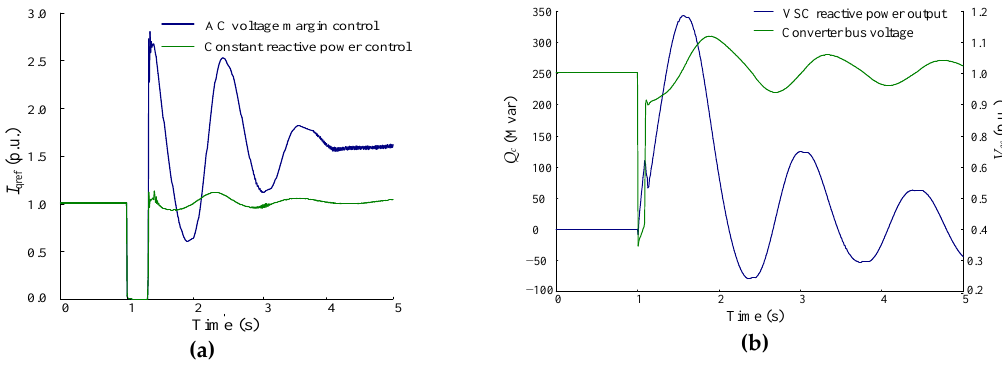
Figure 8. Dynamic responses for di ff erent reactive power control modes under AC-side fault. ( a ) q axis